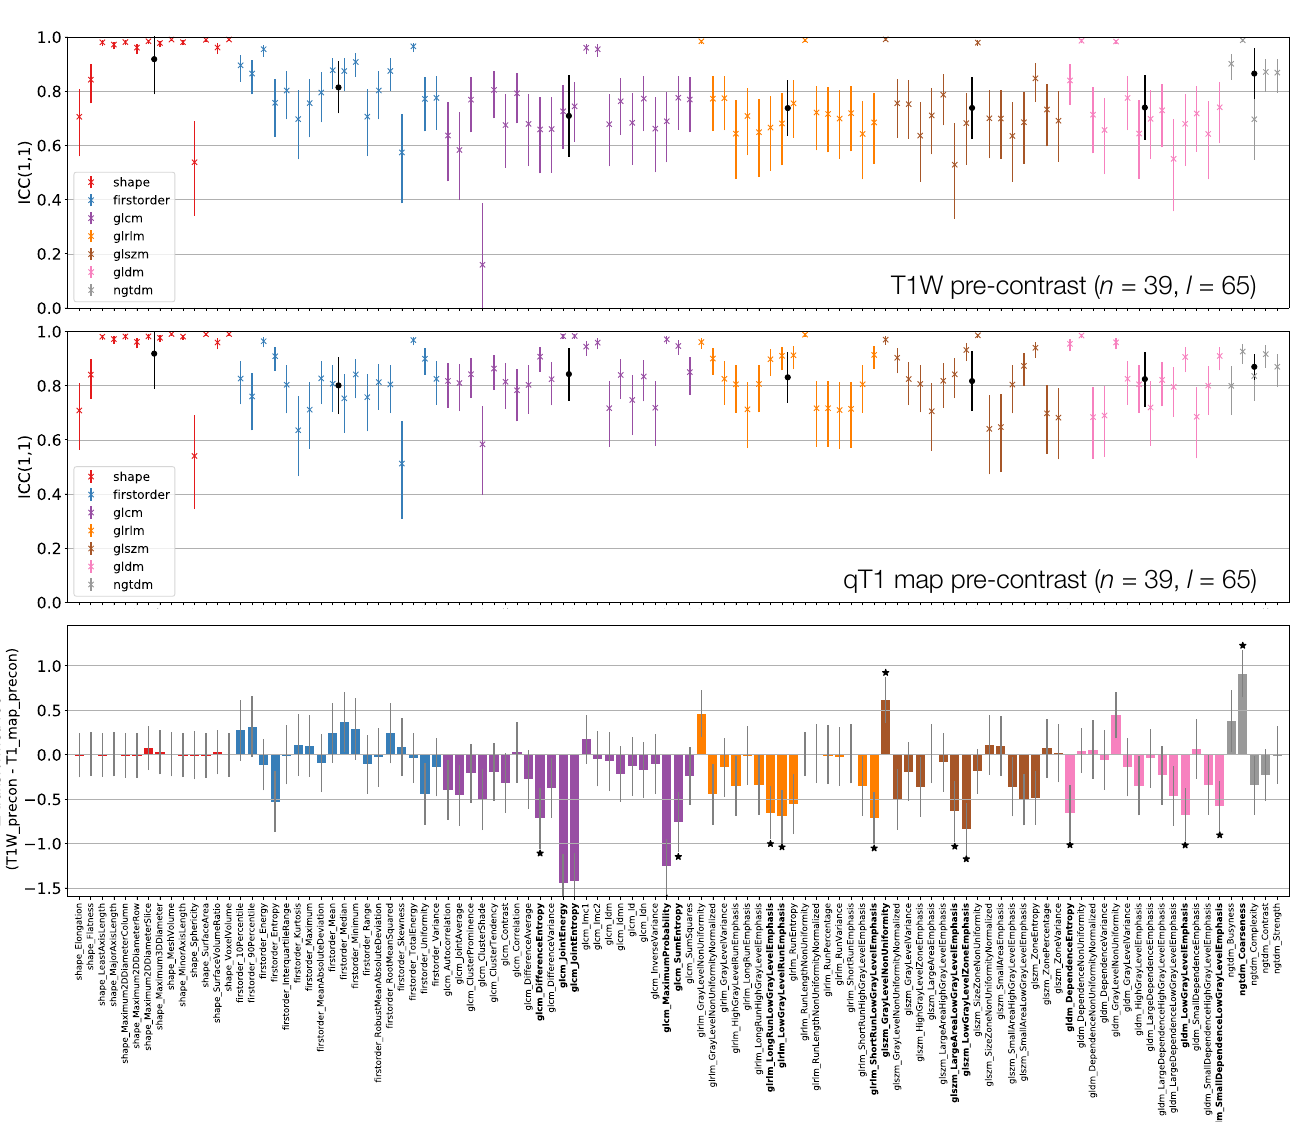
Figure 7. ICCs for Box–Cox transformed features from T 1 W (top) and qT 1 map (middle) pre-contrast images. Data points and error bars represent ICC point estimates and 95% CIs. Features are colour coded according to their class and black points correspond to mean ± standard deviation ICCs over features within each class. The bottom panel represents the difference in ICCs (after applying Fisher’s Z -transformation) for T 1 W and qT 1 map pre-contrast images. Black stars and bold fonts indicate features where ICCs from the two sequences are significantly different.